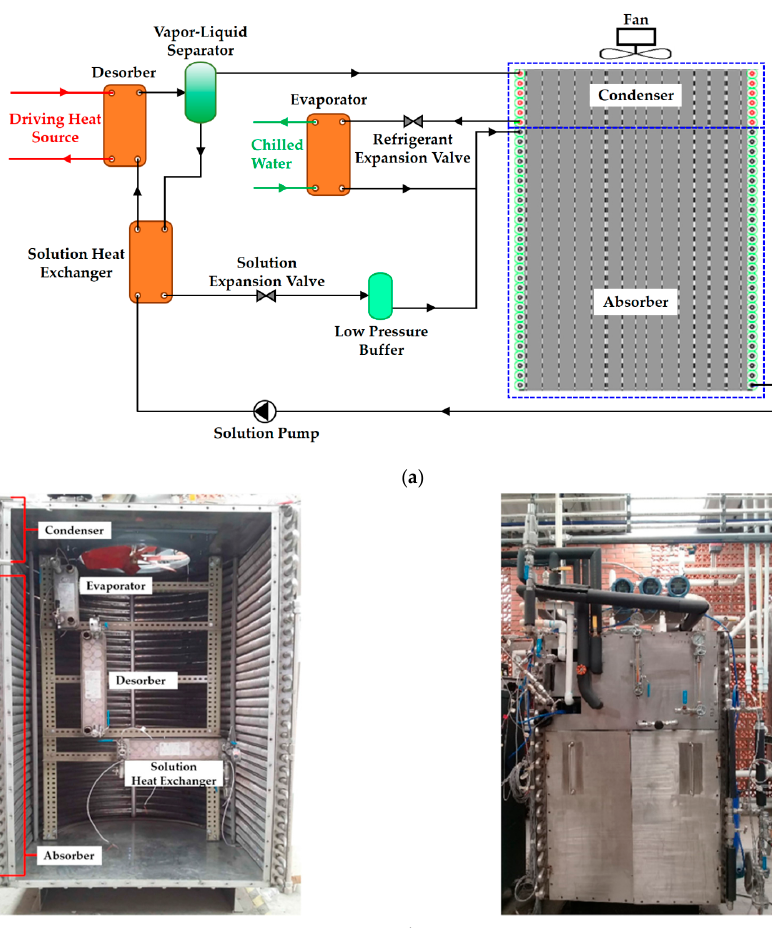
Figure 15. Air ‐ cooled, single ‐ effect ammonia/LiNO 3 absorption chiller laboratory prototype Figure 15. Air-cooled, single-e ff ect ammonia / LiNO 3 absorption chiller laboratory prototype developed developed by Soto and Rivera [64]. (a) Schematic diagram; (b) Prototype internal and external views. by Soto and Rivera [64]. ( a ) Schematic diagram; ( b ) Prototype internal and external